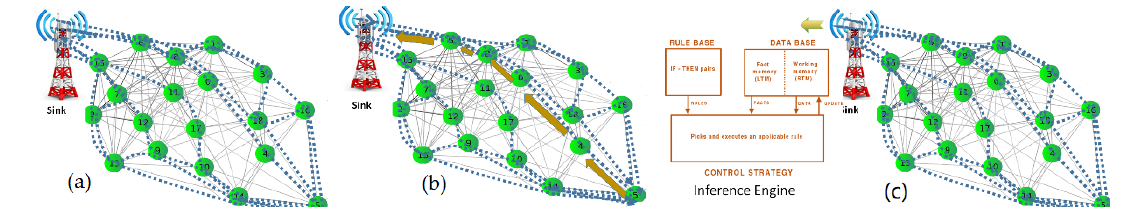
Figure 8. Fault detection approaches: ( a ) proactive; ( b ) active and ( c )